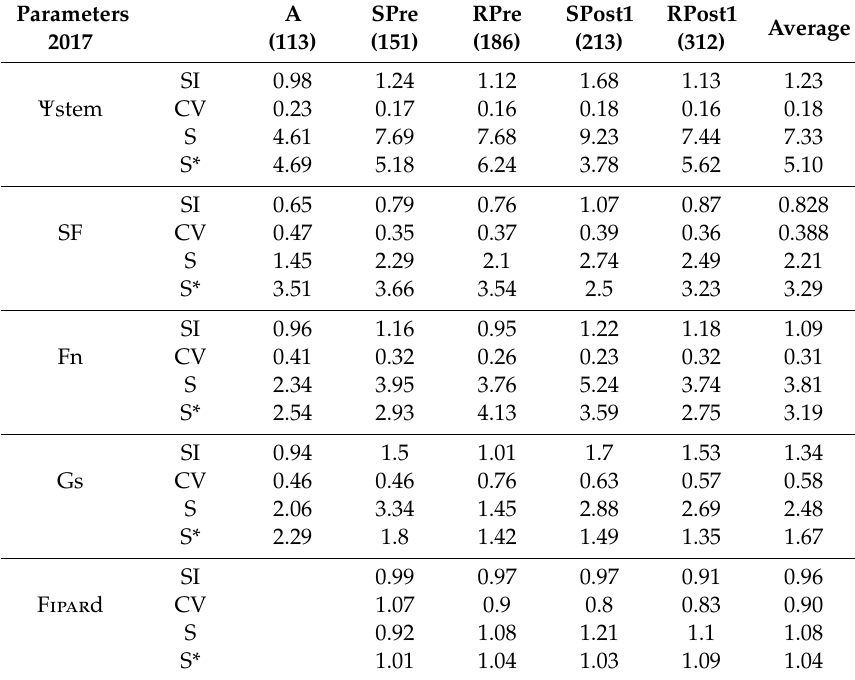
Table 5. Mean values of each parameter in the CON and D treatments, signal intensity, coe ffi cient of variation and sensitivity determined according to the traditional (S) and corrected (S*) method in